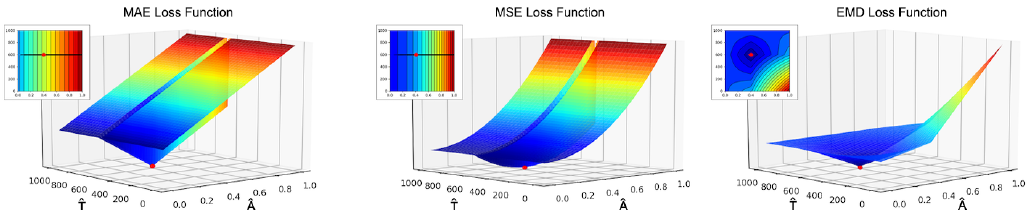
Figure 12. Behaviour of MAE, MSE and Earth Mover Distance (EMD loss functions varying amplitude ˆ A and position ˆ T of the predicted direct